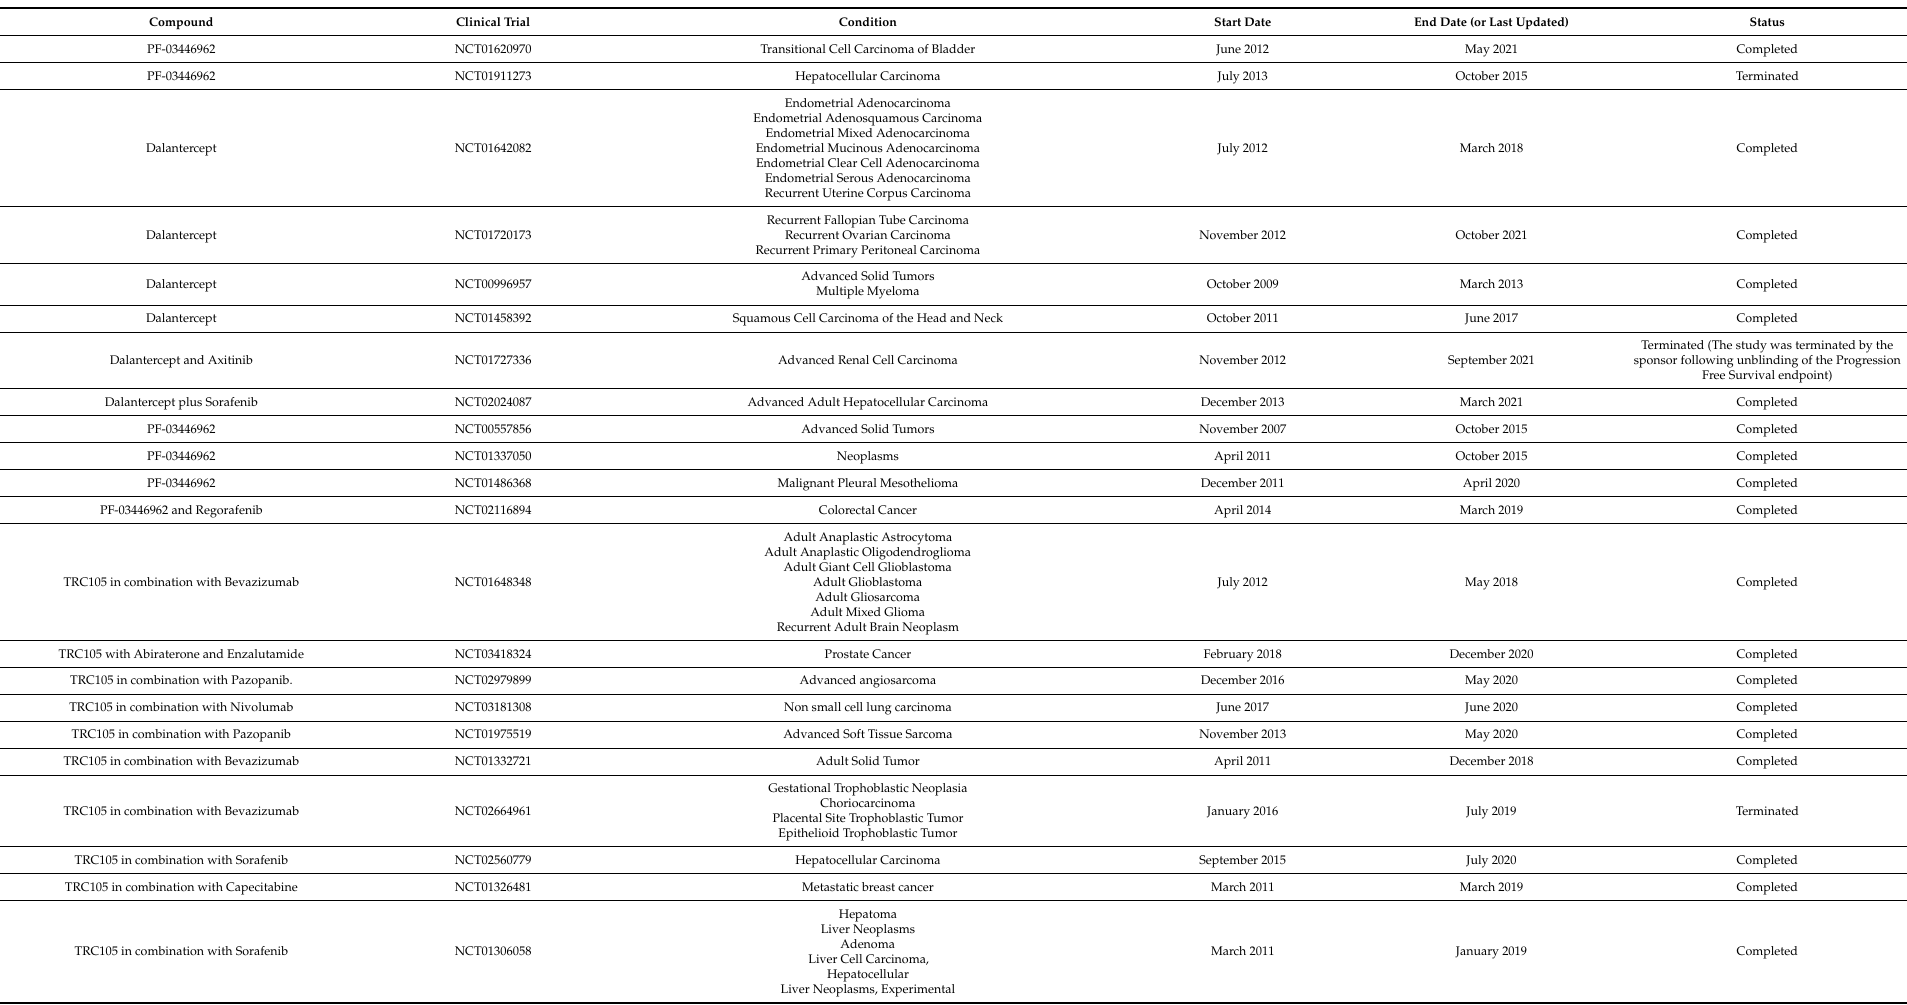
Table 1. ALK1 and endoglin inhibitors in clinical trials for cancer